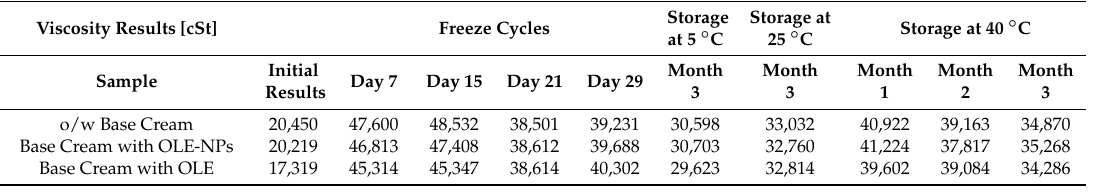
Table 5. Results of the viscosity measurements during the stability